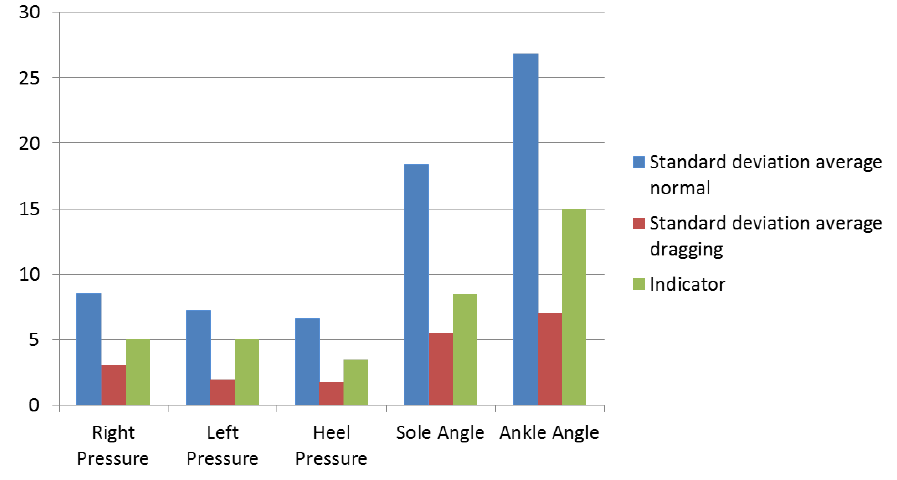
Figure 28. Comparison between the standard deviations average and the